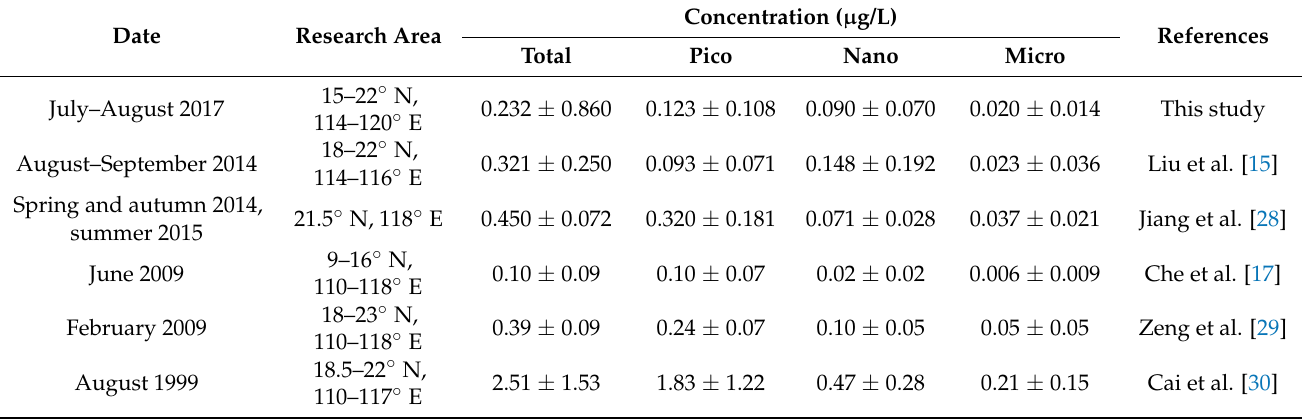
Table 4. Historical data of the size-fractionated Chl a in the South China